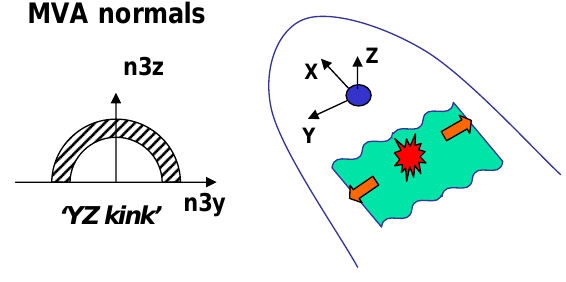
Fig. 11. Scheme showing predicted distributions of MVA normals in the YZ plane for “YZ-kink” type of surface (neutral sheet)